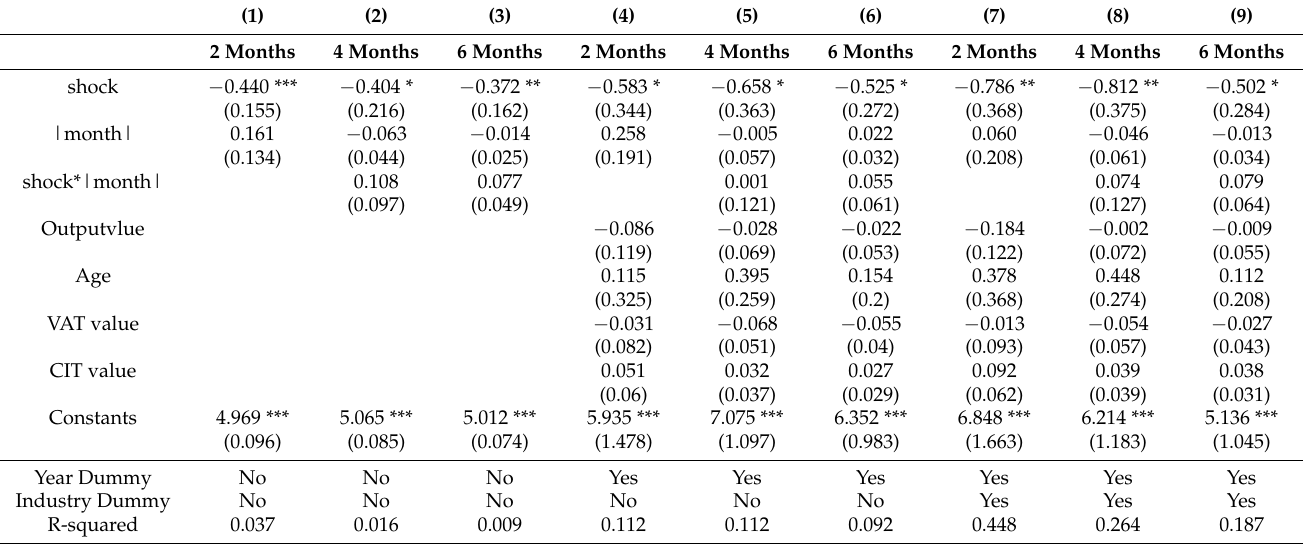
Table 6. The effect of tax collection reform on land prices by using parametric